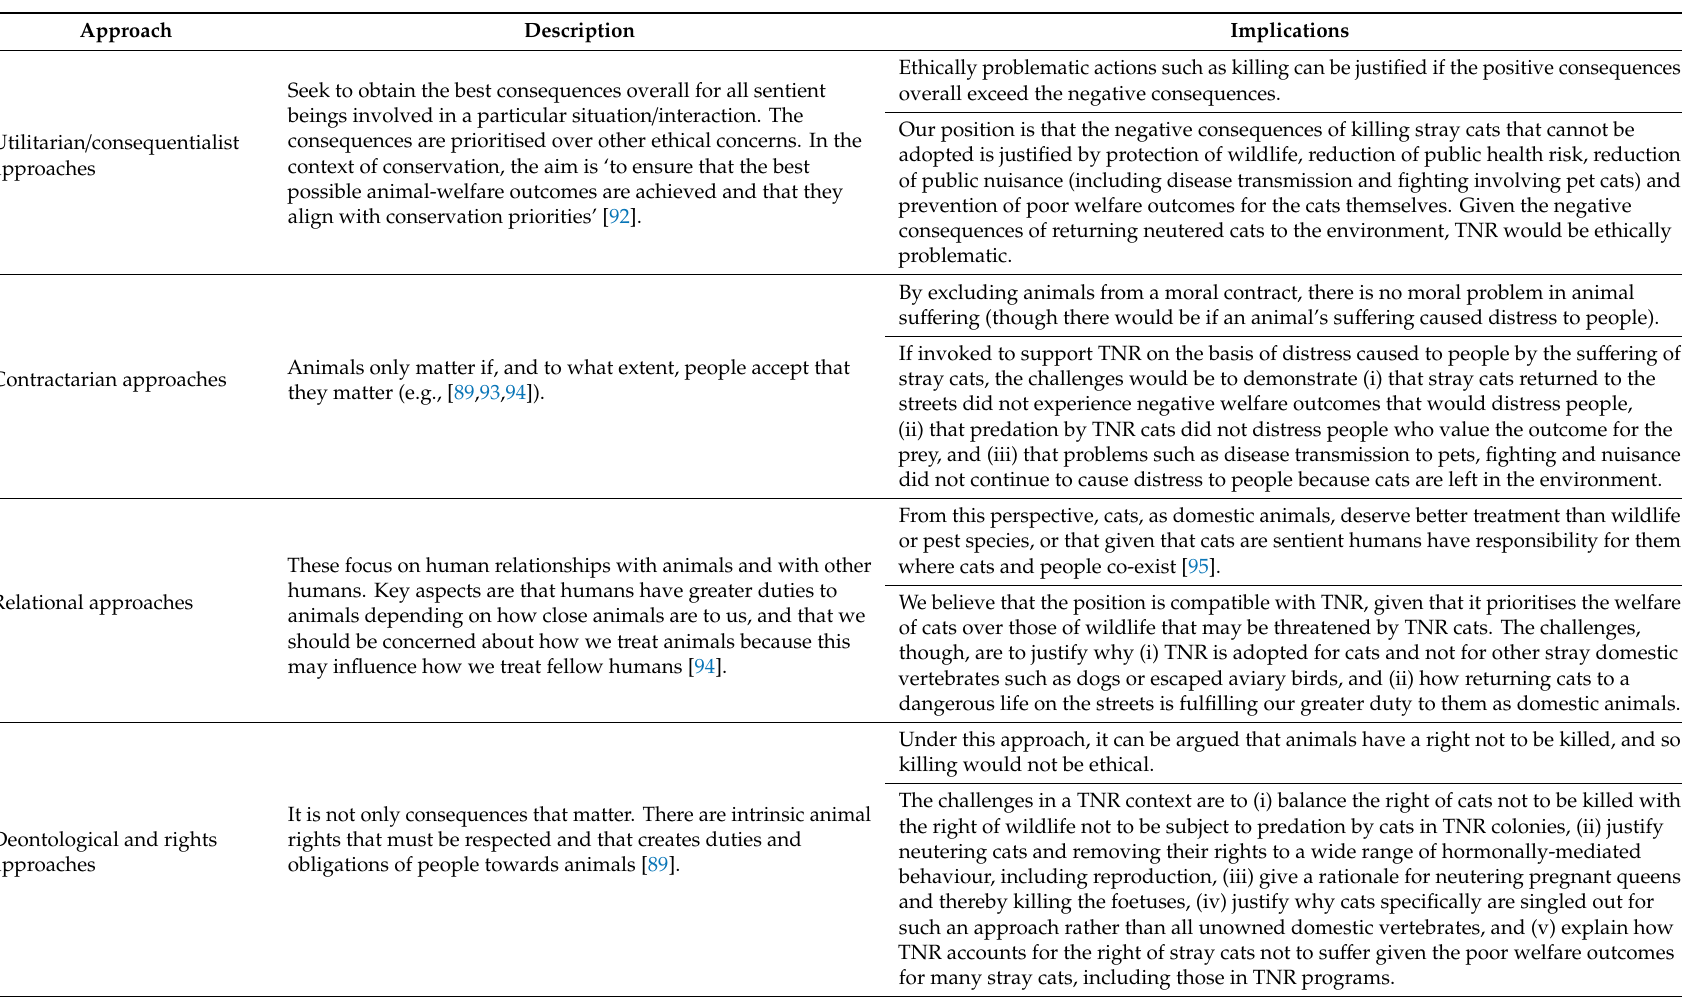
Table 2. Common ethical approaches to companion animal ethics, adapted from Sandøe et al. (2015), Hampton et al. (2019) and Animal Ethics Dilemma (undated). Alternative classifications are